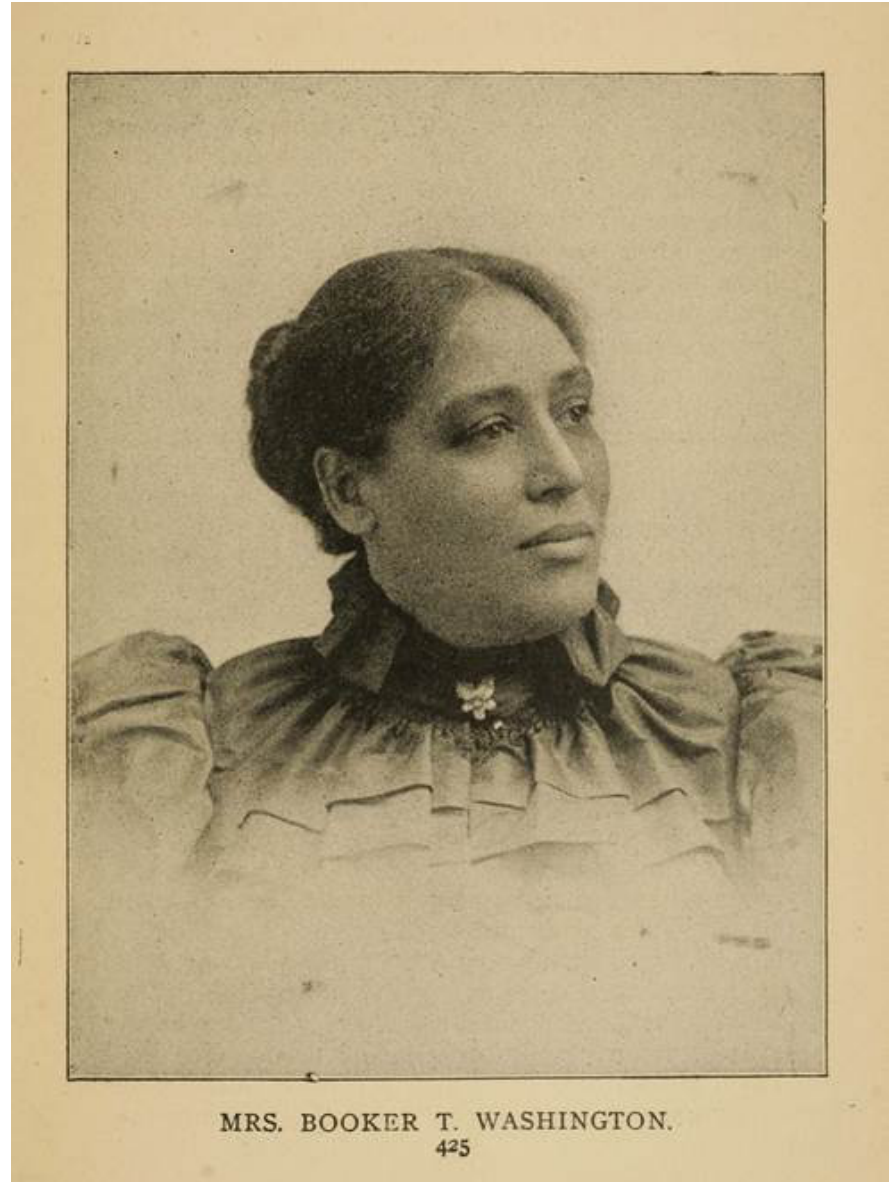
Figure 3 Portrait of Mrs. Booker T. Washington from A New Negro for a New Century .